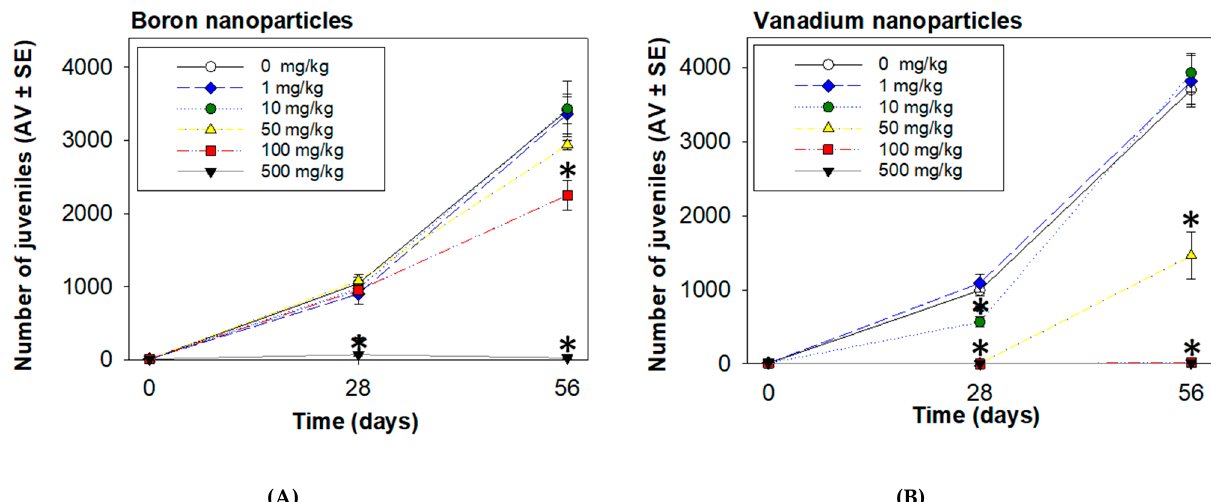
Figure 5. Effects on Enchytraeus crypticus reproduction, after 28 vs. 56 d exposure to boron nanoparticles ( A ) and vanadium nanoparticles ( B ) in LUFA 2.2 soil. Results are expressed as average value (AV) ± standard error (SE) (n = 4). * Significant differences to control ( p < 0.05).